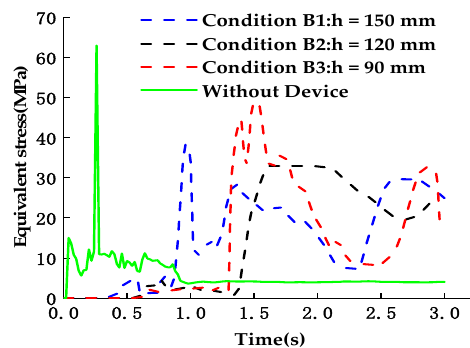
Figure 22. Equivalent stress curve of the pier impact area.